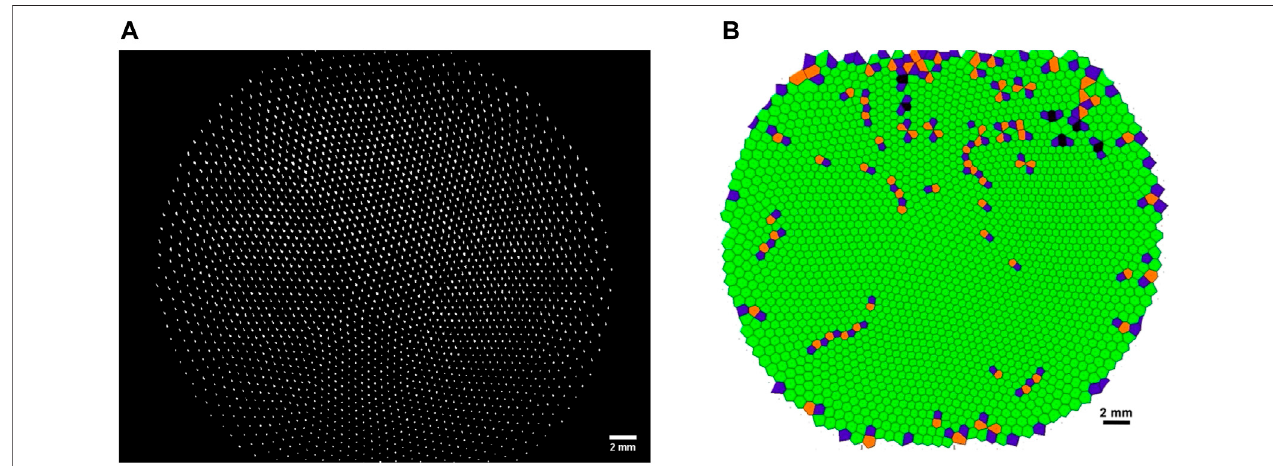
FIGURE 4 | Top-view image (A) of the 2D dust crystal when the plasma was on, and the microspheres were levitated steadily at a height of 13.9 mm above the lower electrode. The crystalline structure in the microsphere arrangement seen in (A) is veri fi ed by the Voronoi diagram (B) , which we obtained by analyzing the